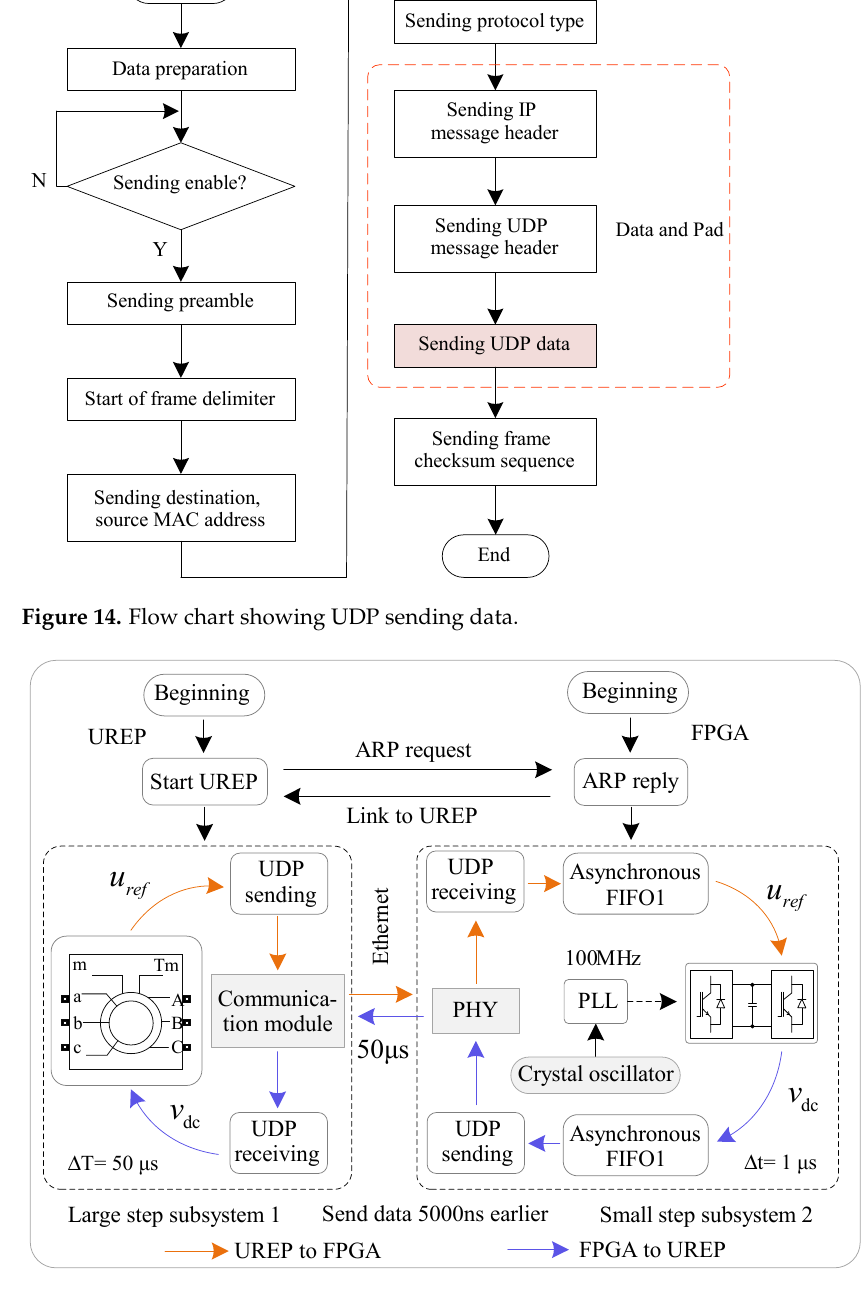
Figure 15. FPGA–UREP asynchronous parallel simulation framework.